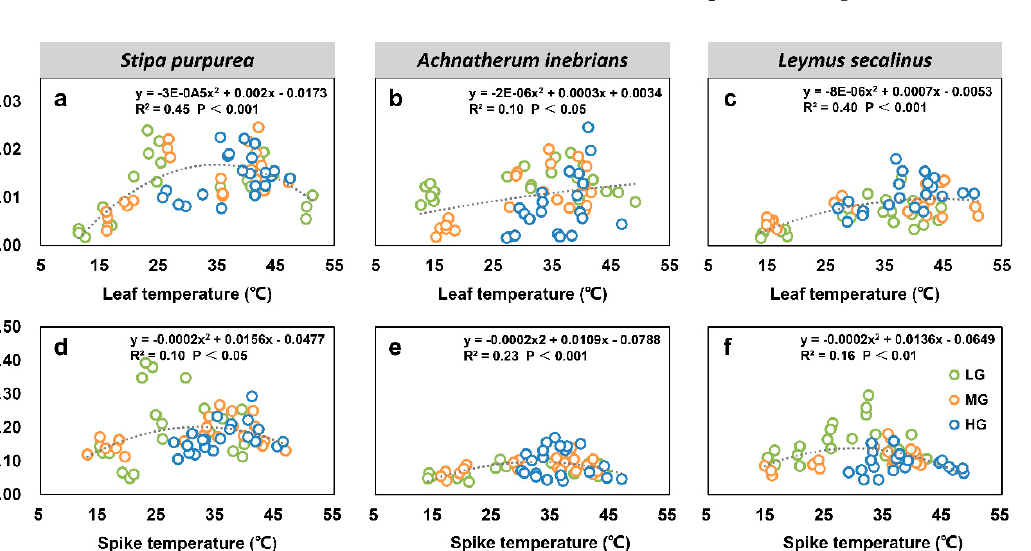
Figure 8. Correlations between leaf net photosynthetic rate (Pn) and leaf temperature (T l ) (top), and between spike Pn and spike temperature (T s ) (bottom) of S. purpurea ( a , d ), A. inebrians ( b , e ) and L. secalinus ( c , f ) under grazing intensity (LG, light grazing; MG, medium grazing; HG, heavy grazing).